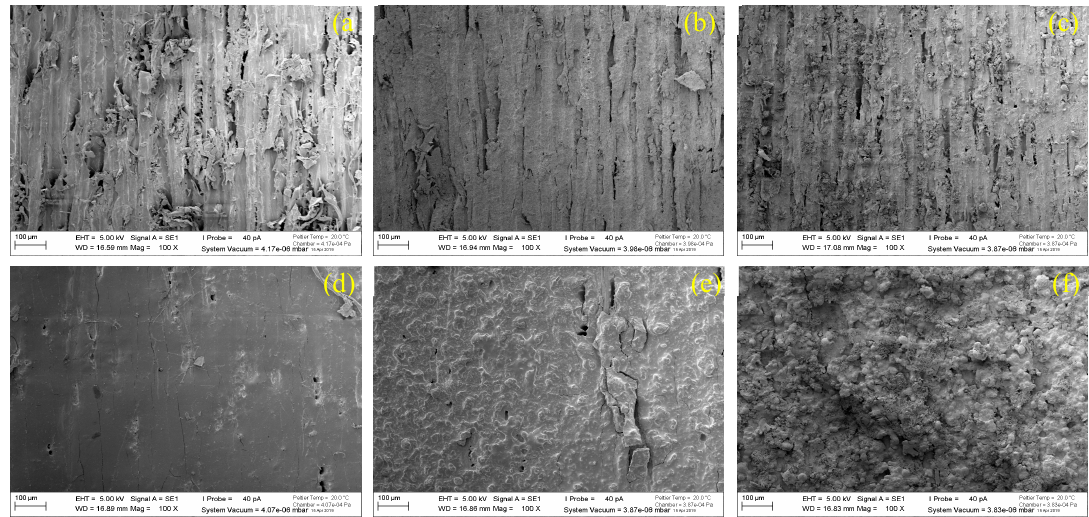
Figure 8. SEM images of pine wood ( a ) with different coatings: ( b ) Bi, ( c ) eCon, ( d ) polyester, ( e ) PBi and ( f ) PeCon after water uptake and release test.